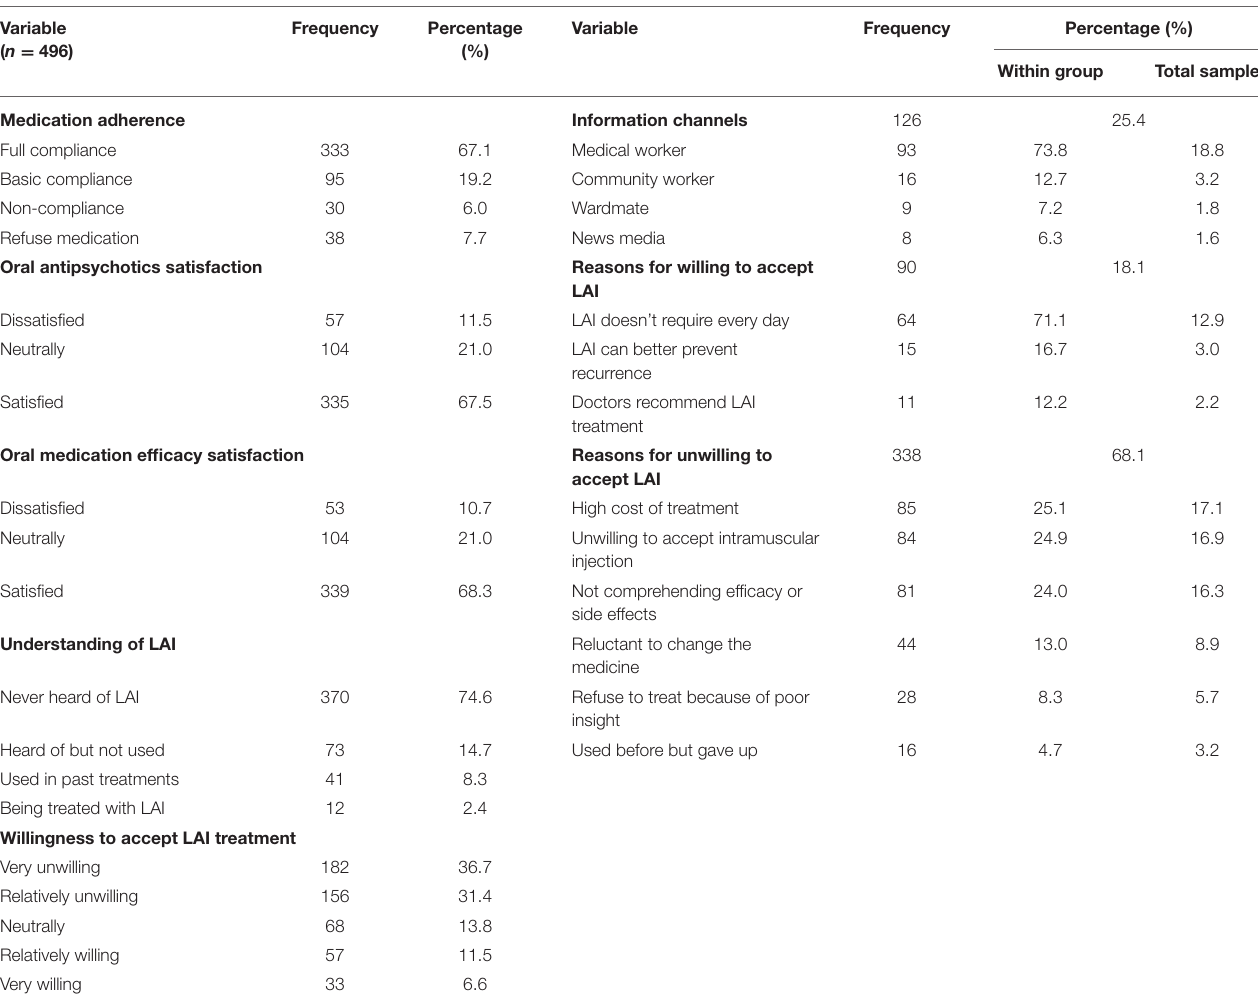
TABLE 2 | Description of issues related to treatment and reasons to accept LAI